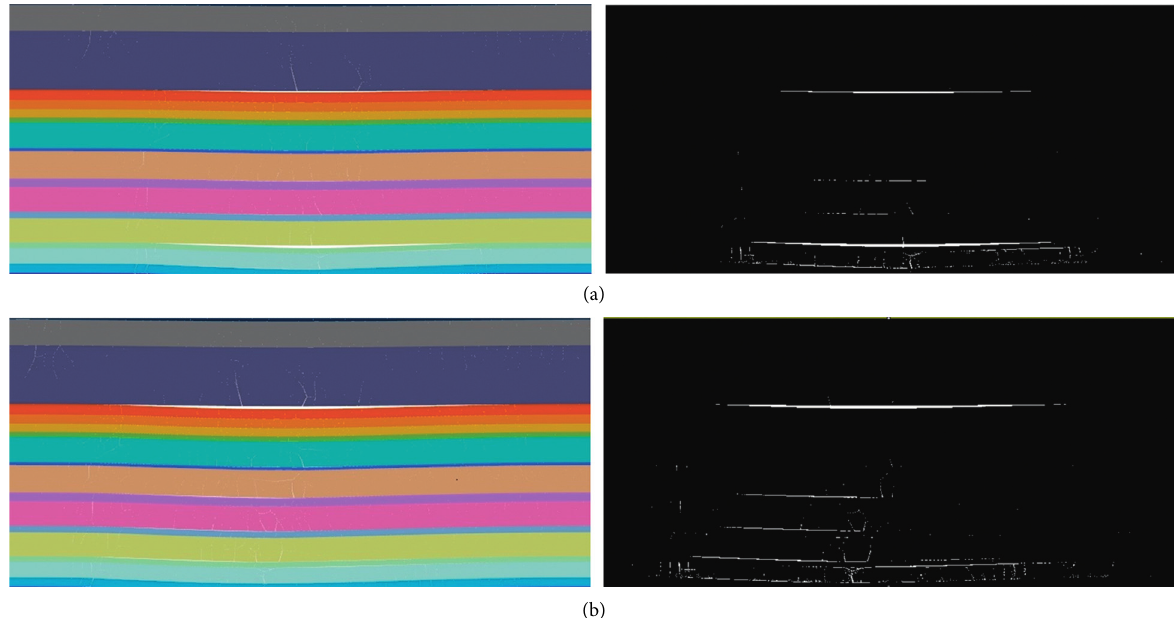
Figure 9: The converted binary image of the bed separation zone. (a) Longwall face advancing 210m. (b) Longwall face advancing